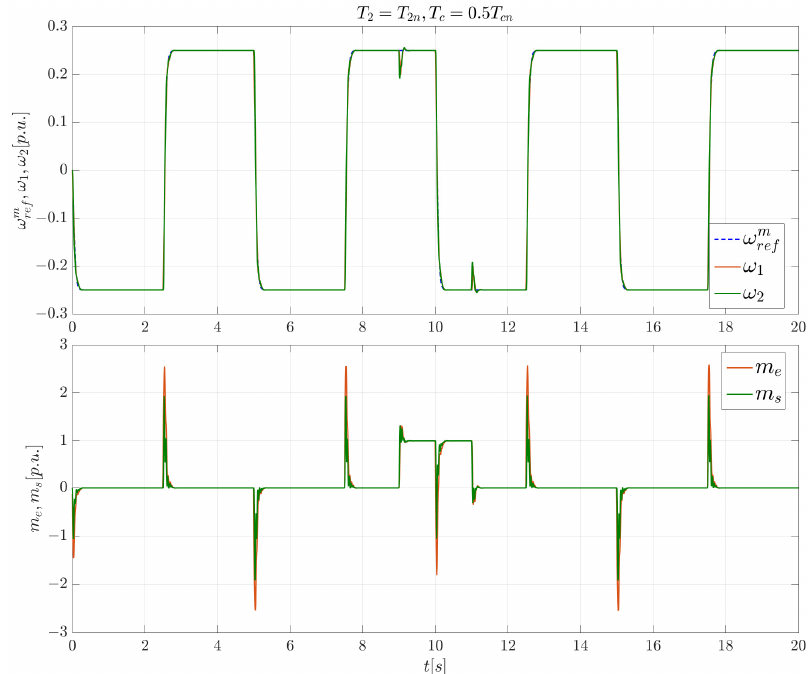
Figure 11. Speeds ( ω ref , ω 1 , and ω 2 ) and torques ( m e and m s )—transients for the decreased shaft time constant ( T c = 0.5 T cn ).